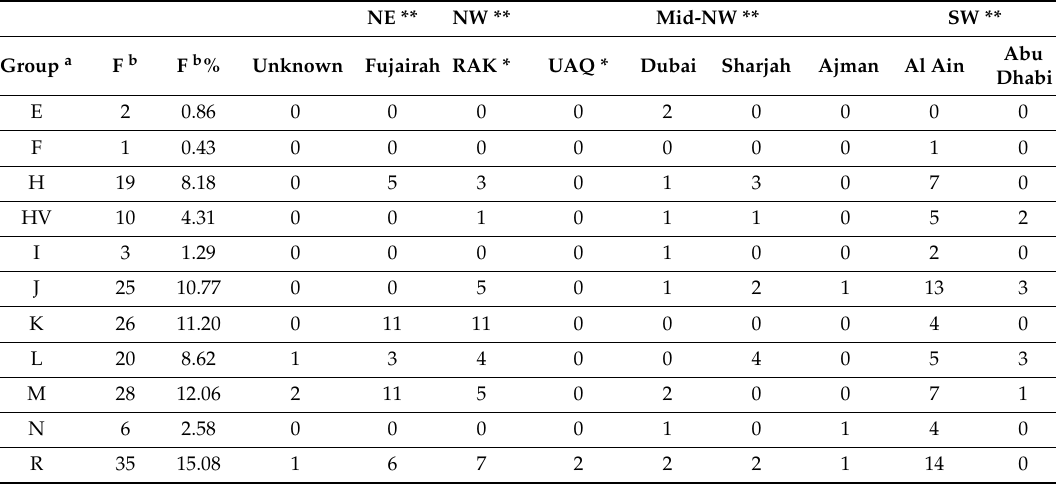
Table 1. UAE population haplogroup